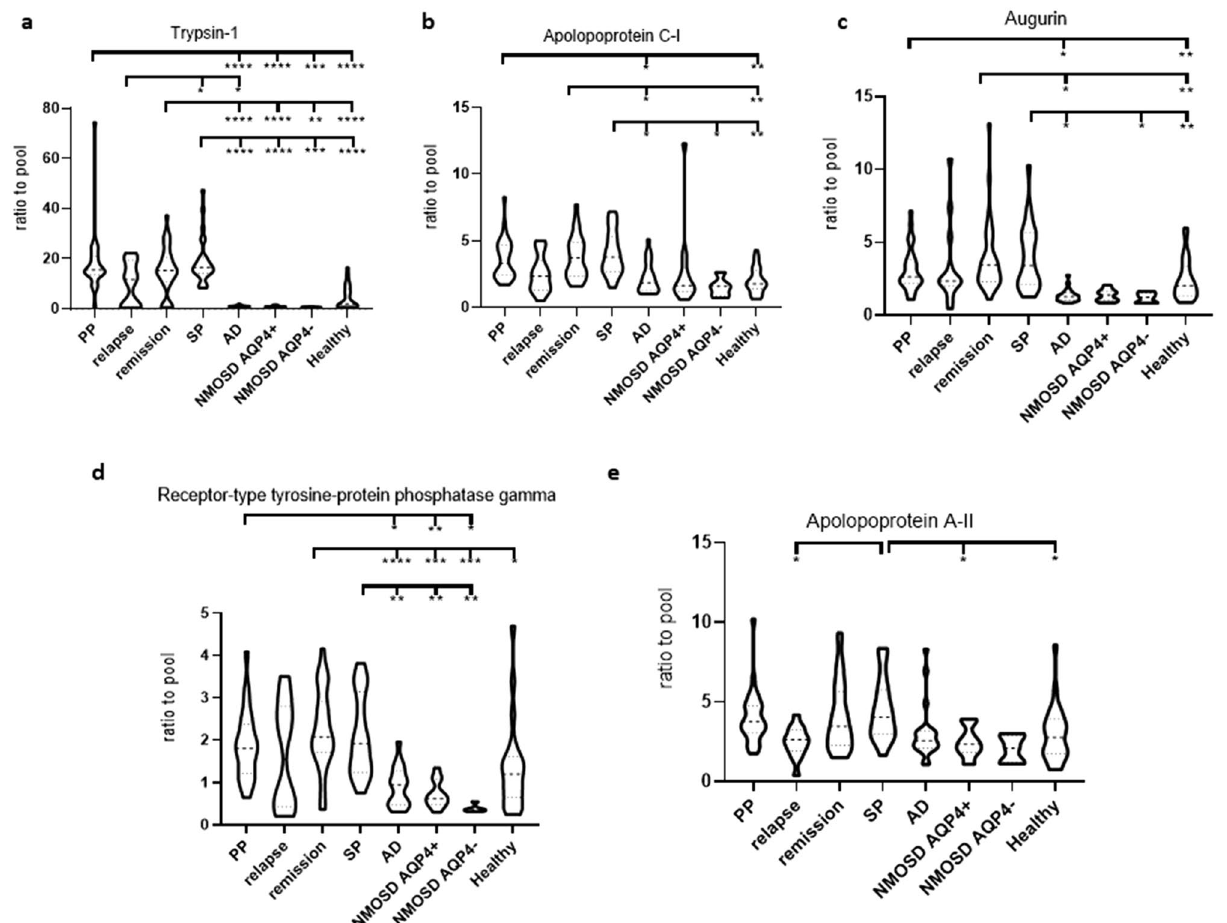
Figure 5. Significantly upregulated unique molecular markers in the CSF of MS subtypes. Overview of 5 proteins significantly upregulated in the CSF of MS subtypes compared to other CNS diseases and healthy controls. ( a ) Trypsin-1 that was significantly upregulated in remission, PPMS and SPMS compared to disease- and healthy controls in individual samples (detection: PP = 30 of 30; relapse = 14 of 14; remission = 33 of 33; SP = 26 of 26; AD = 22 of 22; NMOSD AQP4 + = 13 of 13; NMOSD AQP4 − = 5 of 5; healthy = 27 of 27). ( b ) Apolipoprotein C-I and ( c ) augurin were significantly upregulated in remission, PPMS and SPMS compared to AD and healthy controls in individual samples. (detection: PP = 30 of 30; relapse = 14 of 14; remission = 33 of 33; SP = 26 of 26; AD = 22 of 22; NMOSD AQP4 + = 13 of 13; NMOSD AQP4 − = 5 of 5; healthy = 27 of 27). ( d ) Receptor-type tyrosine-protein phosphatase gamma was significantly upregulated in remission, PPMS and SPMS compared to disease controls (detection: PP = 25 of 27; relapse = 12 of 14; remission = 27 of 33; SP = 20 of 26; AD = 18 of 22; NMOSD AQP4 + = 11 of 13; NMOSD AQP4 − = 5 of 5; healthy = 22 of 27). ( e ) Apolipoprotein A-II was uniquely significantly upregulated in SPMS compared to MS in relapse, NMOSD AQP4 + and healthy controls (detection: PP = 30 of 30; relapse = 14 of 14; remission = 33 of 33; SP = 26 of 26; AD = 22 of 22; NMOSD AQP4 + = 13 of 13; NMOSD AQP4 − = 5 of 5; healthy = 27 of 27). PP/SP primary/secondary progressive multiple sclerosis, AD Alzheimer disease, NMOSD AQP4 +/− neuromyelitis optica spectrum disorder positive/negative for aquaporin-4 antibody